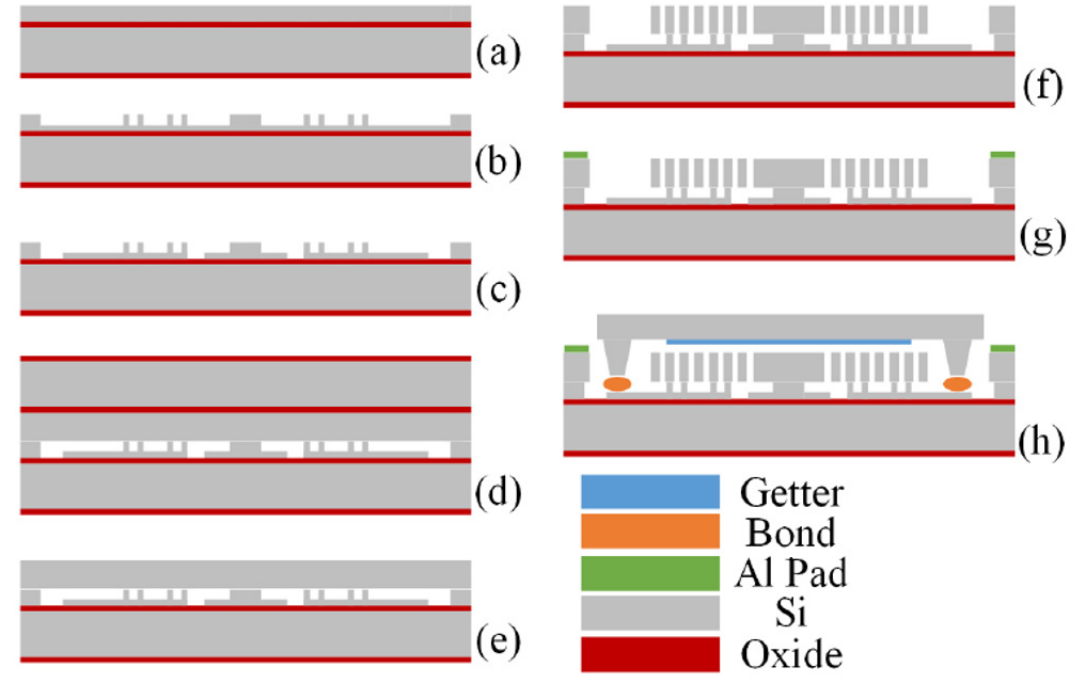
Figure 3. The fabrication process flow of the gyroscope. ( a ) a 6-inch SOI wafer with a 100 μ m thick top device layer was